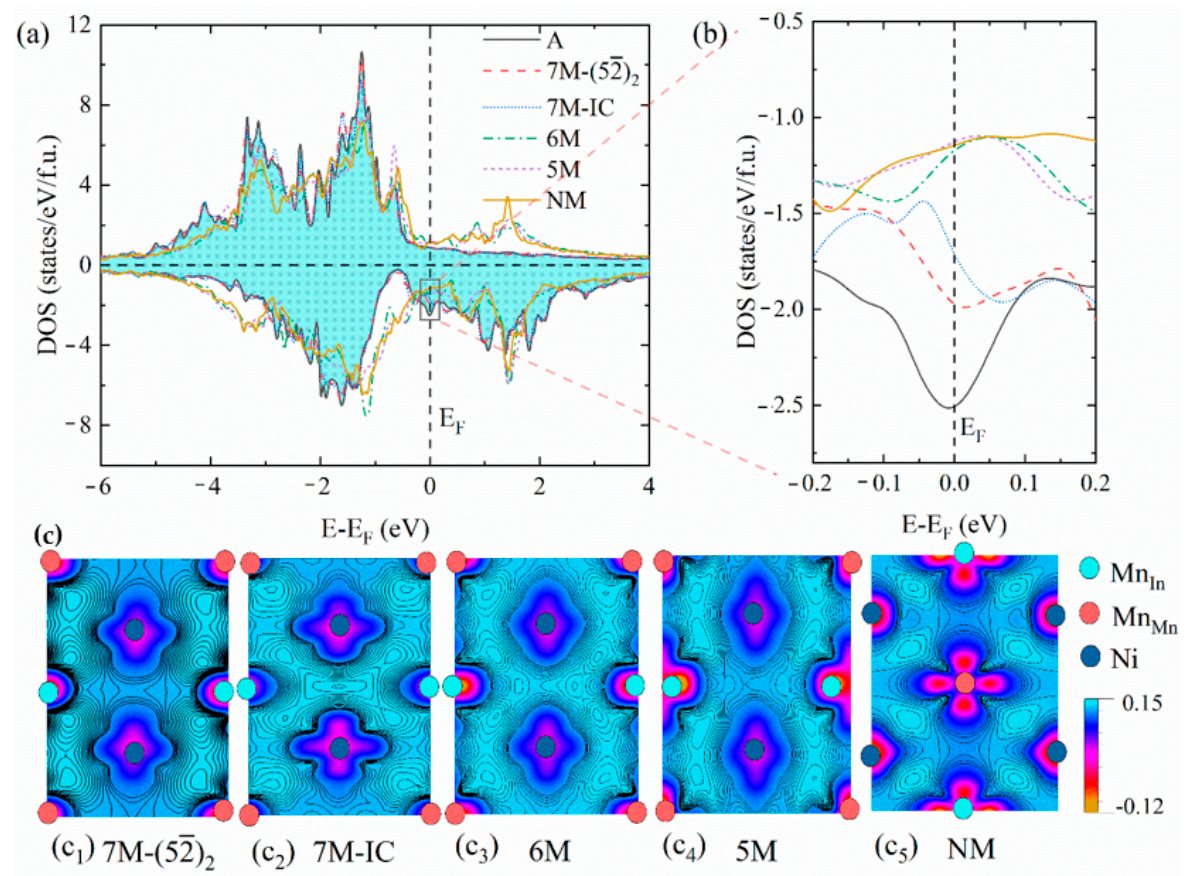
Figure 5. ( a ) Total density of states of A, 5M, 6M, 7M − ( 52 ) , 7M–IC, and NM phases of Ni 2 Mn 1.5 In 0.5 alloy, ( b ) enlarged spin-down density of states near the E F , and ( c ) differential charge densities of different martensitic structures in plane with excess Mn In atoms.